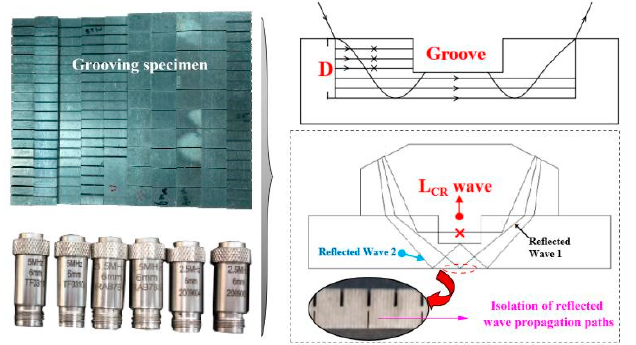
Figure 11. Schematic of L CR wave penetration depth test.